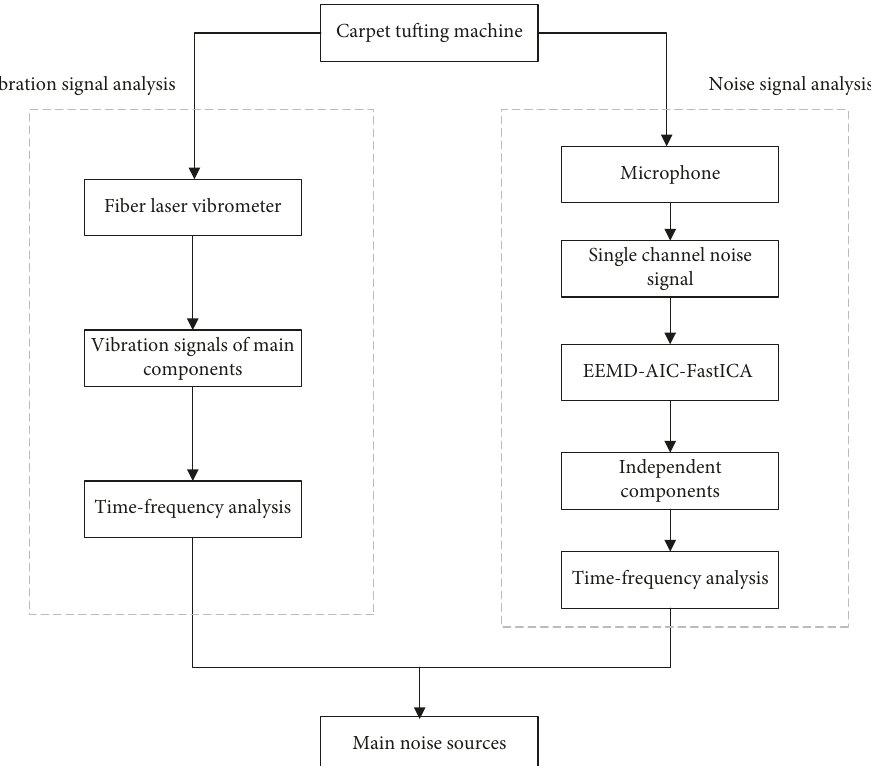
Figure 3: Schematic of the noise source identification of the carpet tufting machine.